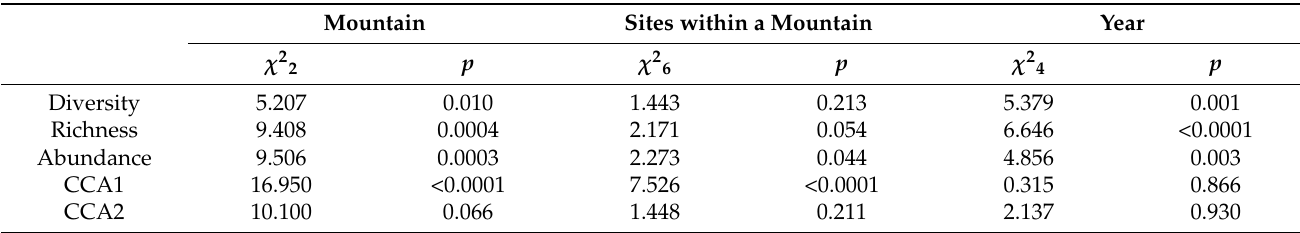
Table A4. Generalized linear models (GLMs) of carabid beetle